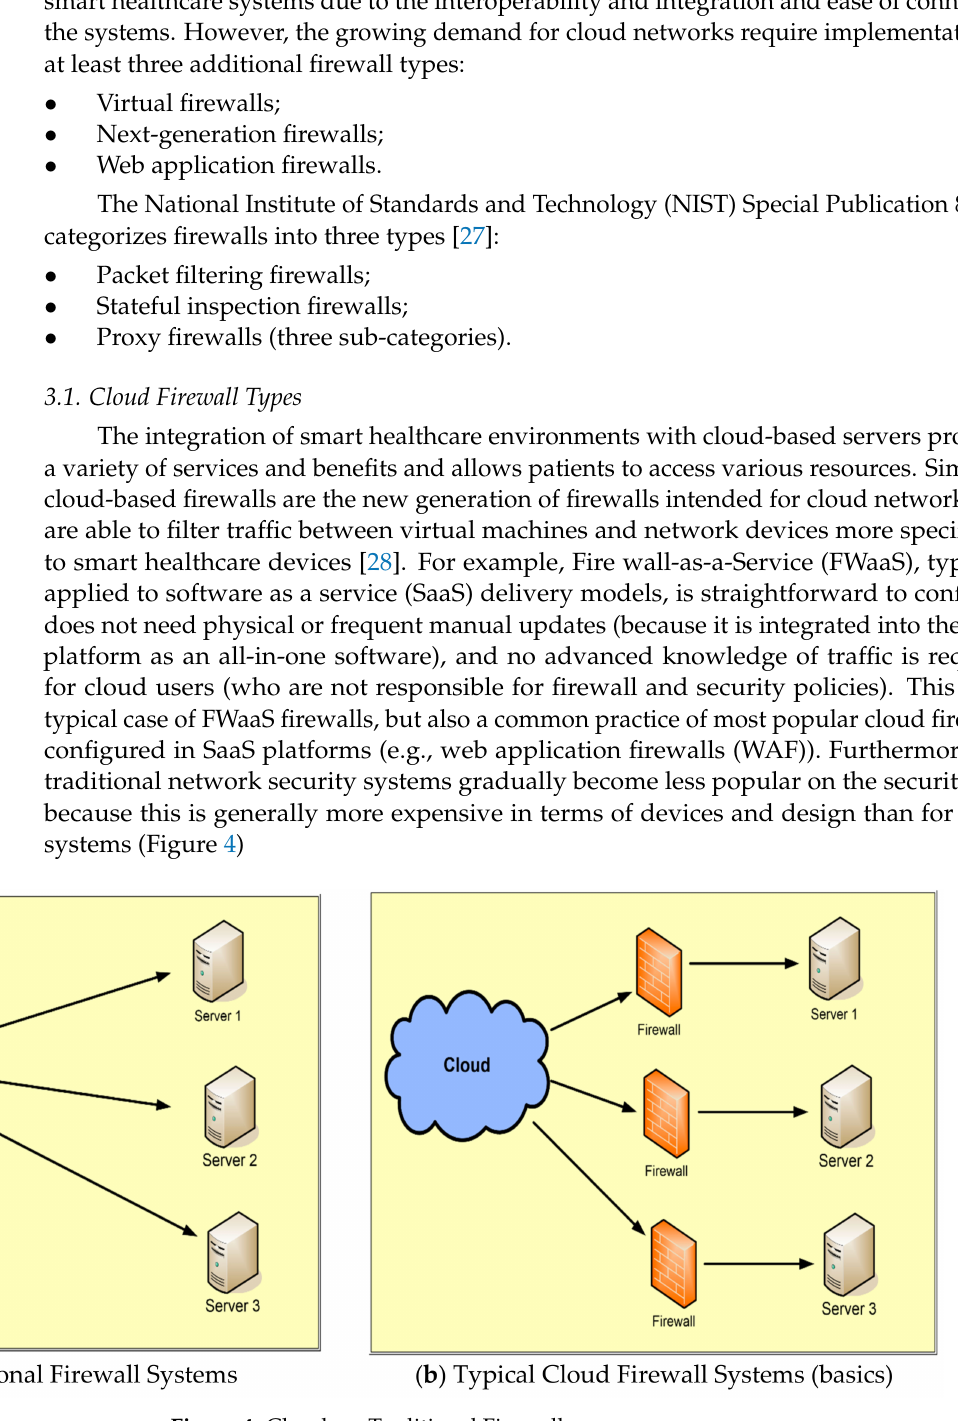
Figure 4. Cloud vs. Traditional